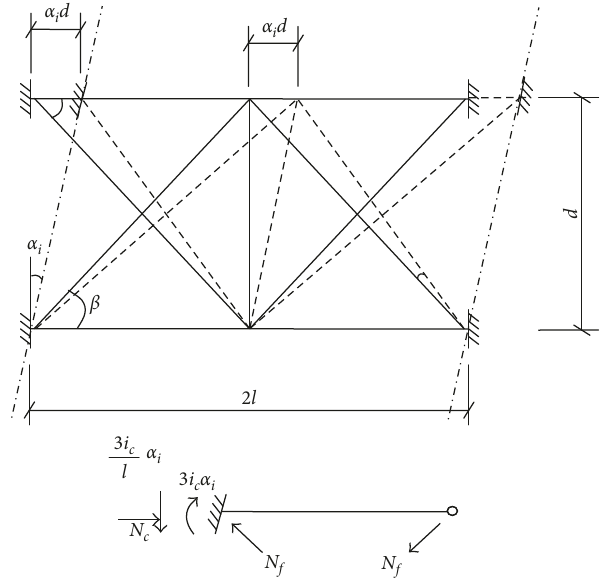
Figure 1: Deformation mode and internal force of steel truss